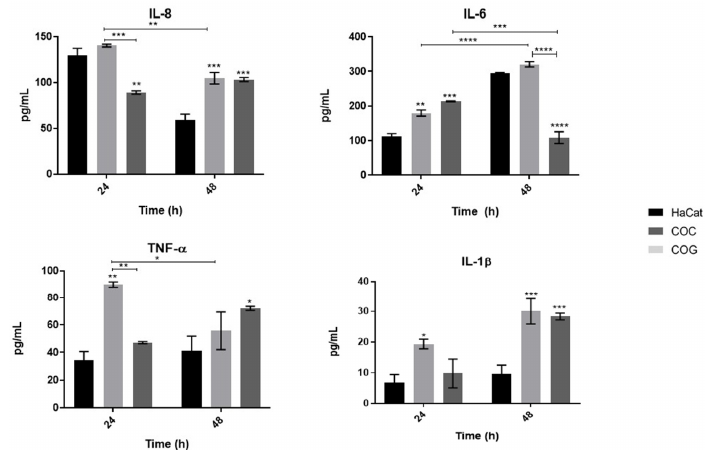
Figure 1. Secretion of cytokines by human keratinocytes during co-culture with fungal elements of T. rubrum . HaCat: cultured keratinocytes used as control; COC: co-culture with the conidial phase of T. rubrum ; COG: co-culture with the germinative phase of T. rubrum . Asterisks indicate significant differences (* p < 0.05; ** p < 0.01; *** p < 0.001; **** p < 0.0001). 3.3. Analysis of Expression of Human Genes Involved in the Innate Immune Response and Epithelial Barrier Integrity during Co-Culture with T. rubrum To gain further insight into the modulation of the genes identified in the dual- RNAseq experiment previously published by our research group [10], we evaluated the expression levels of the human genes CSF2 , RNASE7 , SERPINE1 , SLC11A1 , KRT1 , and FLG in the COC and COG co-culture conditions at 24 and 48 h (Figure 2). Among the genes involved in the host’s innate immune response, the CSF2 gene was found to be up- regulated (higher fold change), especially in the COC condition, with higher expression at 48 h. Co-culture in the COC and COG conditions promoted differences in the expres- sion levels of the SERPINE1 , FLG , and SLC11A1 genes, suggesting that the expression of